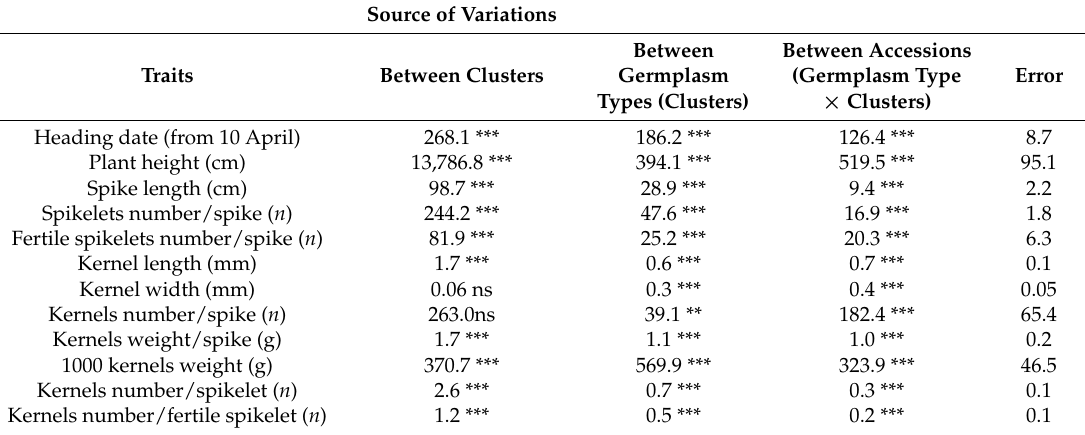
Table 4. Analysis of variance (ANOVA) of 136 durum wheat ex situ accessions and 28 varieties for 12 morphophysiological plant characters comparing the six clusters identified by DAPC, the germplasm types (accessions and varieties) within clusters, and the accessions within type group and cluster.